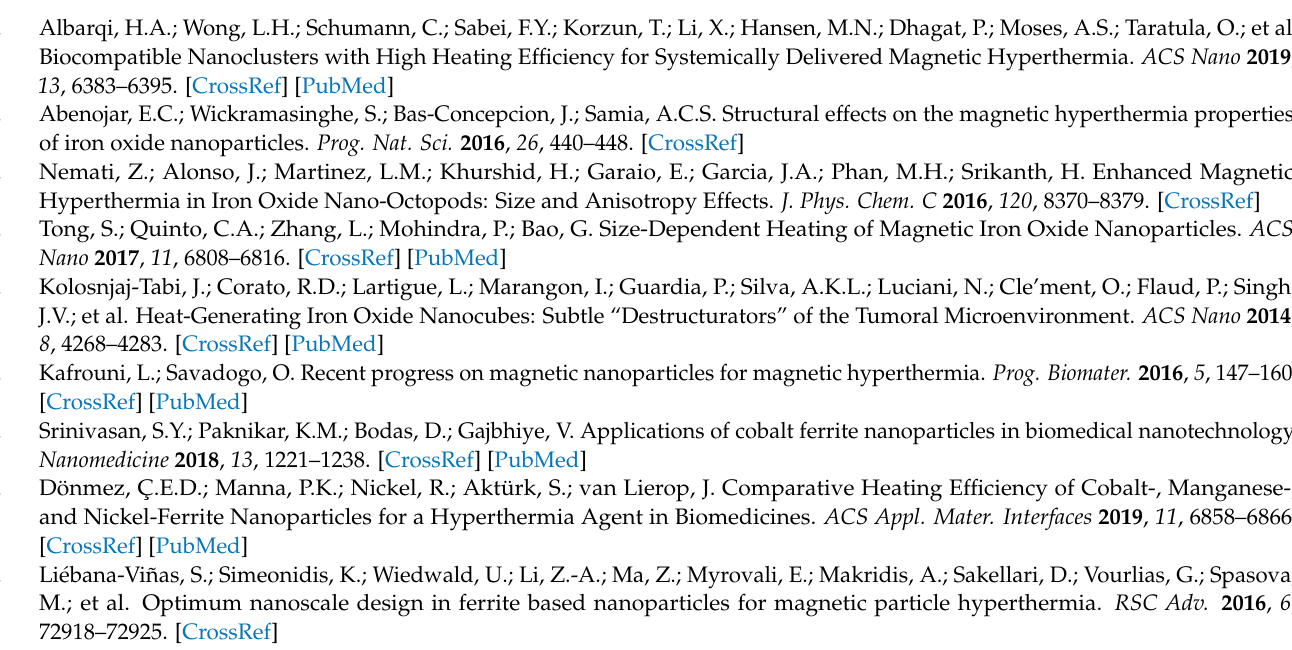
designations: Median/Min ÷ Max/interquartile percentiles (P 25% ÷ P 75% ), Table S18. Assessment of MNPs effect on the female rats leukocyte blood count (in the study of acute toxicity). Table cell designations: Median/Min ÷ Max/interquartile percentiles (P 25% ÷ P 75% ), Table S19. Assessment of MNPs effect on the male mice blood biochemical parameters (in the study of acute toxicity). Table cell designations: Median/Min ÷ Max/interquartile percentiles (P 25% ÷ P 75% ), Table S20. Assessment of MNPs effect on the female mice blood biochemical parameters (in the study of acute toxicity). Table cell designations: Median/Min ÷ Max/interquartile percentiles (P 25% ÷ P 75% ), Table S21. Assessment of MNPs effect on the male rats blood biochemical parameters (in the study of acute toxicity). Table cell designations: Median/Min ÷ Max/interquartile percentiles (P 25% ÷ P 75% ), Table S22. Assessment of MNPs effect on the female rats blood biochemical parameters (in the study of acute toxicity). Table cell designations: Median/Min ÷ Max/interquartile percentiles (P 25% ÷ P 75%